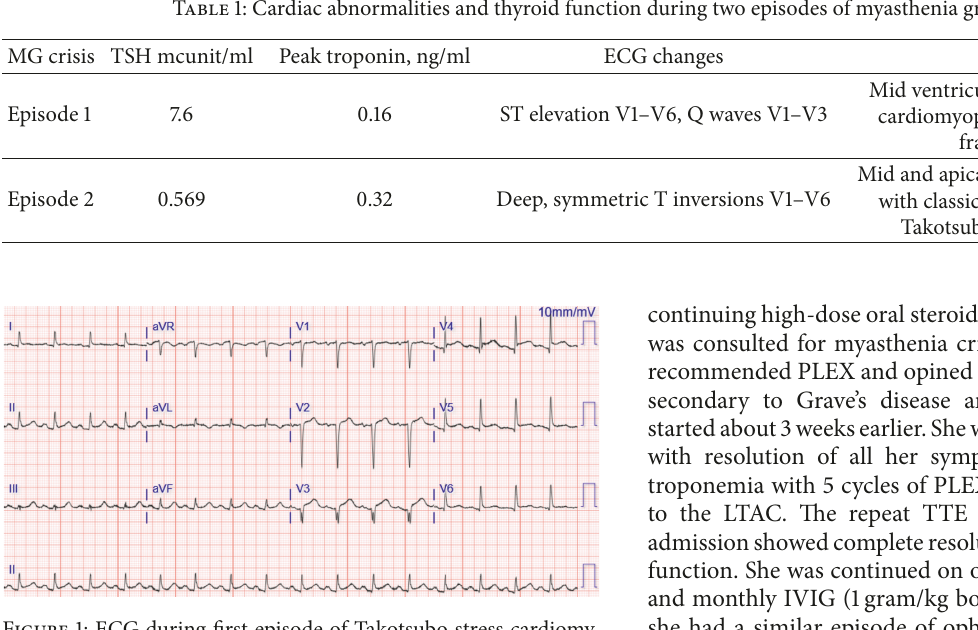
Figure 1: ECG during first episode of Takotsubo stress cardiomy- opathy with ST elevation V1–V6, Q waves in